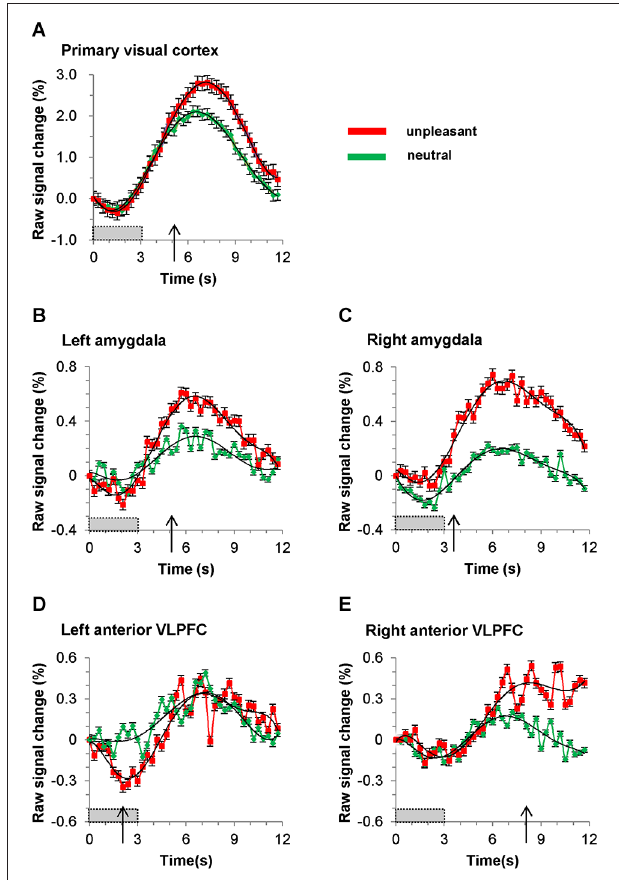
FIGURE 4 | Time course of BOLD signal in (A) primary visual cortex, (B) left amygdala, (C) right amygdala, (D) left anterior VLPFC (BA47) and (E) right anterior VLPFC (BA47) . Red and green plots represent averaged signals (for all nineteen subjects) elicited by unpleasant and neutral pictures, respectively. The gray bars show the picture presentation period, and the arrows show the time at which the BOLD signal during presentation of an unpleasant pictures becomes significantly greater than that during presentation of a neutral picture. The black curved lines are sixth-order polynomial fits, and the error bars show standard